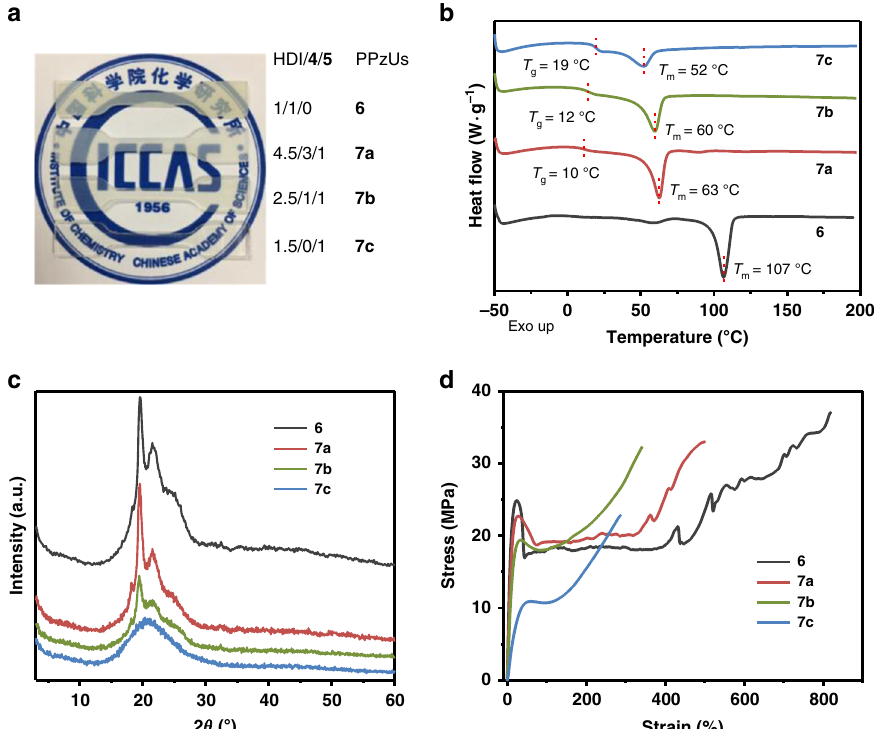
Fig. 4 Characterization of semi-crystalline poly(pyrazole – ureas). a Photographs for PPzUs ( 6 and 7a – c ) with different formulas. b DSC curves of the second heating runs for PPzUs. c XRD analysis of PPzUs. d Stress – strain curves of the as-prepared